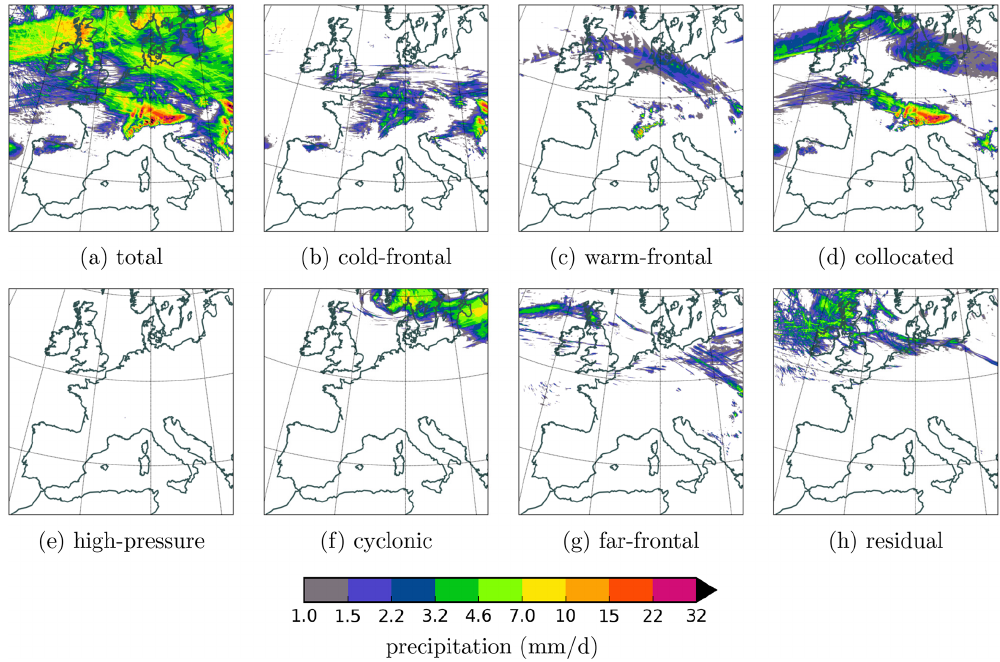
Figure 4. Front–cyclone-relative precipitation contributions to Cyclone Lancelot during the 3d period 19–21 January